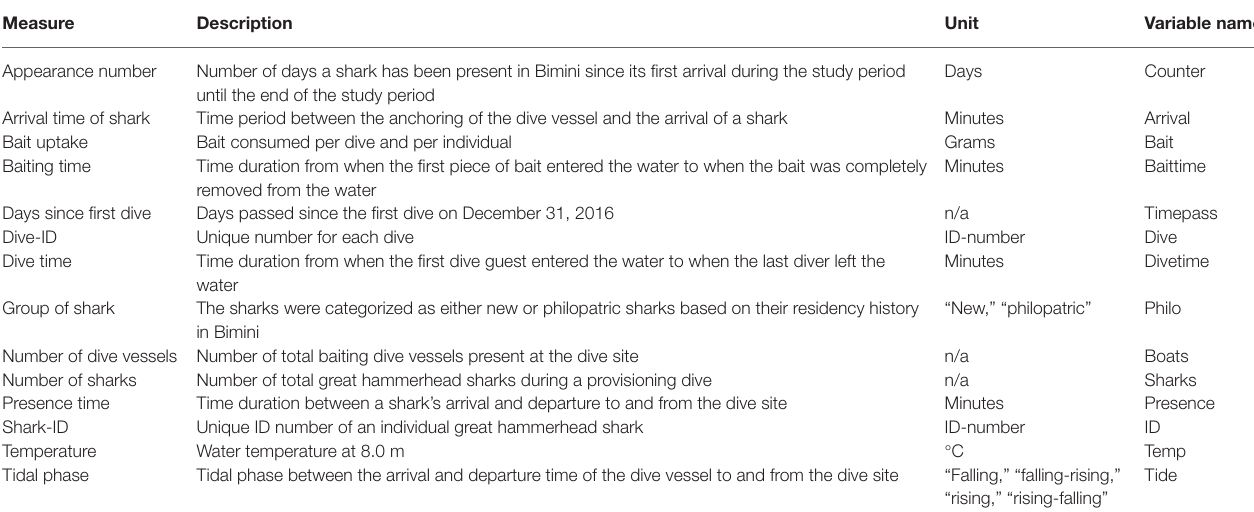
TABLE 1 | Summary and variable names of collected data used in the statistical